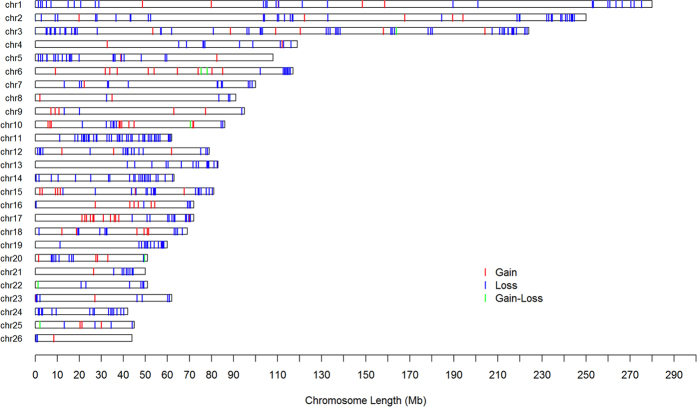
Genomic distribution and status of detected CNVRs among sheep breeds with three different types of tails.Red, green, and blue lines represent the predicted statuses of gain, loss, and gain or loss, respectively.